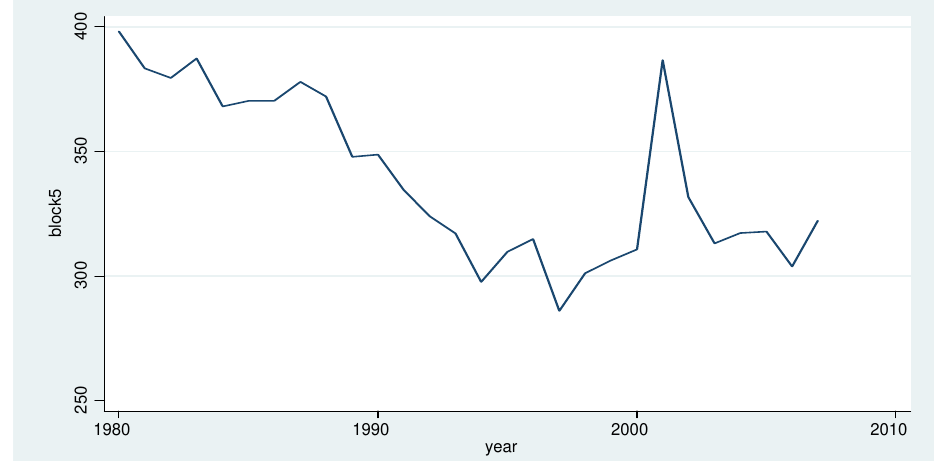
Fig. 3A. Upper consumption block(block 5), yearly average